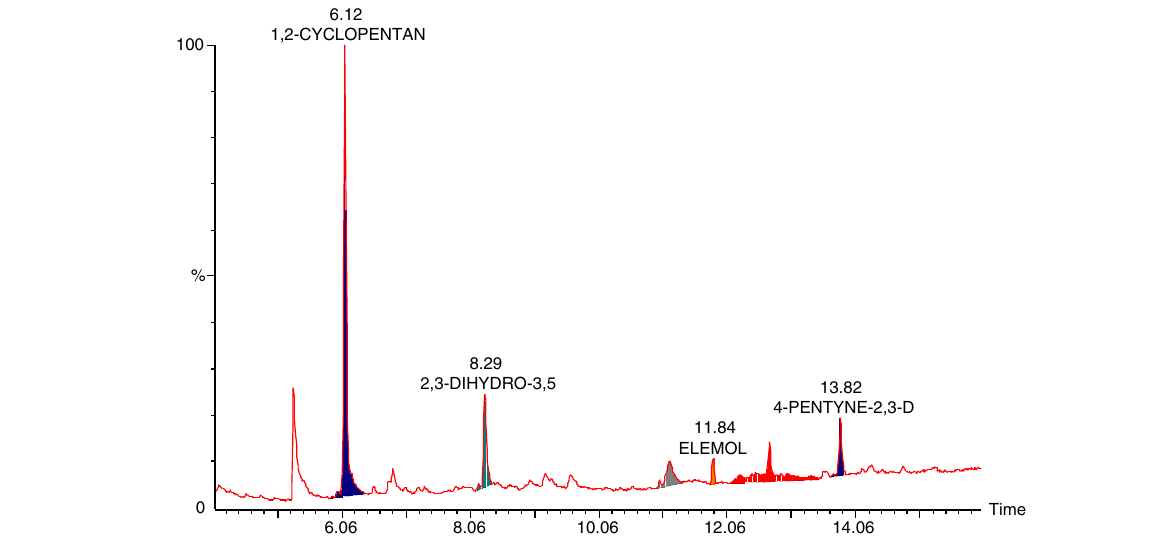
Fig. 2 GC-MS analysis of phytochemical compounds in BG seed methanol extract. The highest peak with least retention time was identified as 1,2- CYCLOPENTANEDIONE which is newly identified compound from the seeds of